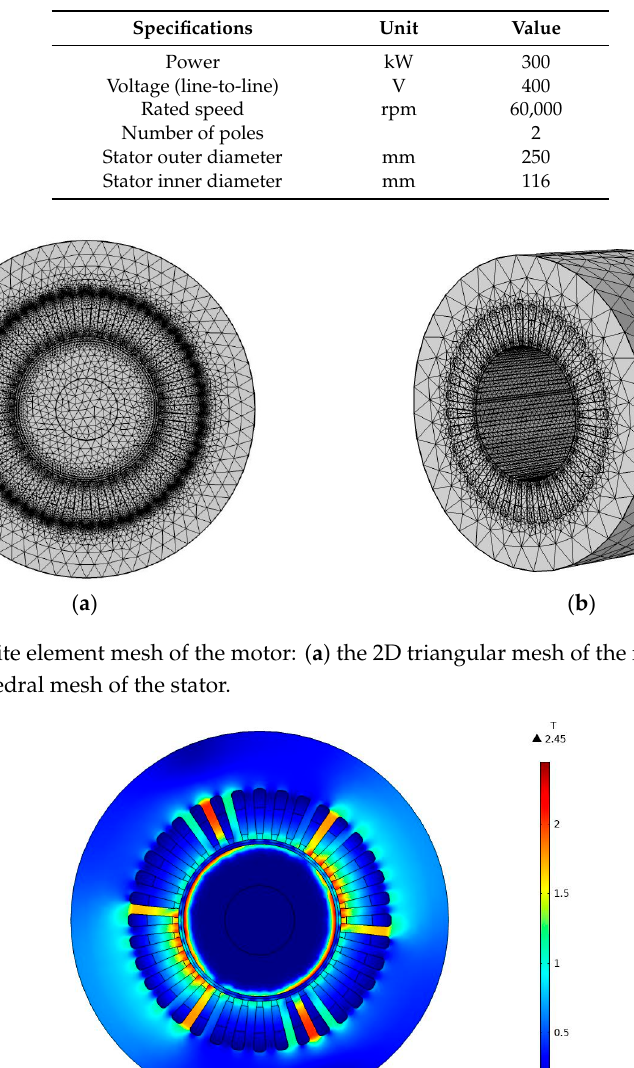
Table 1. The solid rotor induction motor.